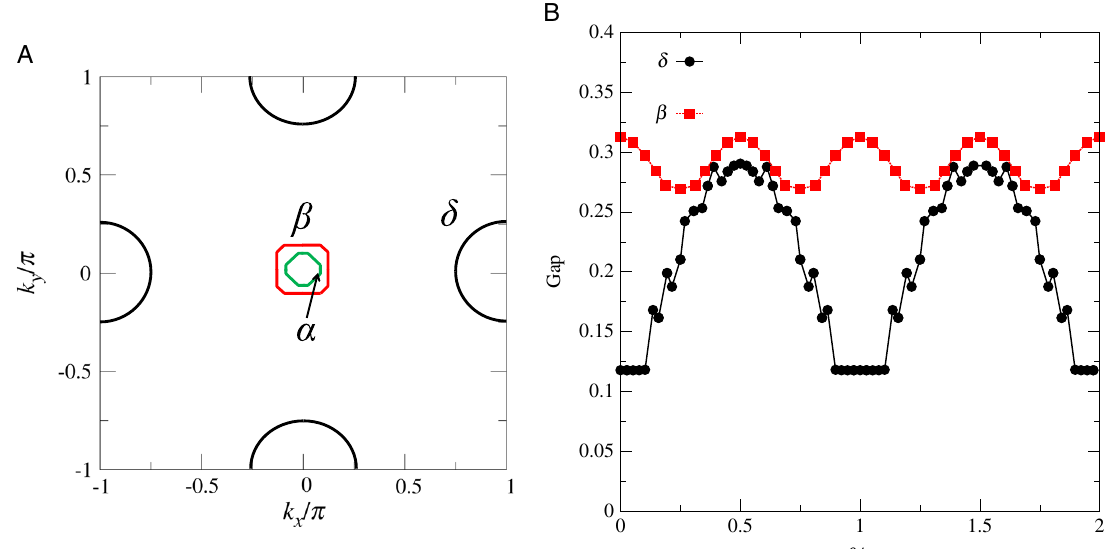
Fig. 5 a The FS for the iron pnictides that includes hole pockets around the Γ point with dominant s τ 3 , B 1 g for J 2 = 1, A L = 1.3, and A O = 0.5. The tight-binding parameters can be found in ref. 27. b The gaps along the β and δ pockets close to the center and edge of the BZ. A similar gap forms around the α